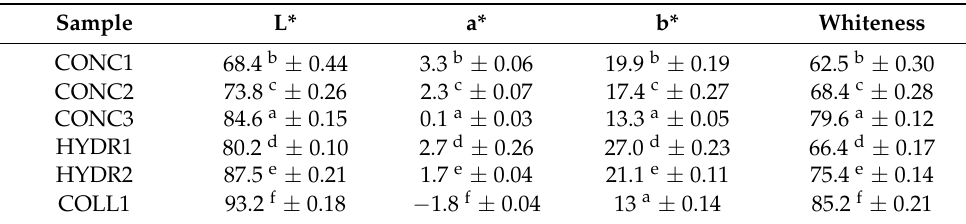
Table 6. The color measurement of the commercial fish protein concentrates, hydrolysates, and hydrolyzed collagen with mean and standard deviation of five replicate measurements. Different letters within the same row indicate a statistically significant difference with ANOVA post hoc pair comparison ( p < 0.05). L* = lightness, a* = red-green, b* =